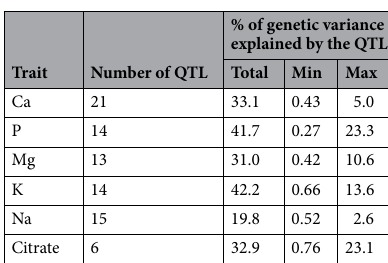
Table 5. Number of QTL and the percentage of genetic variance explained for each